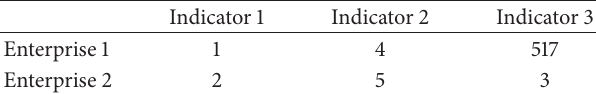
Table 1: Indicator values of a counterexample. Table 2: Nonisotonic indicator value in formula